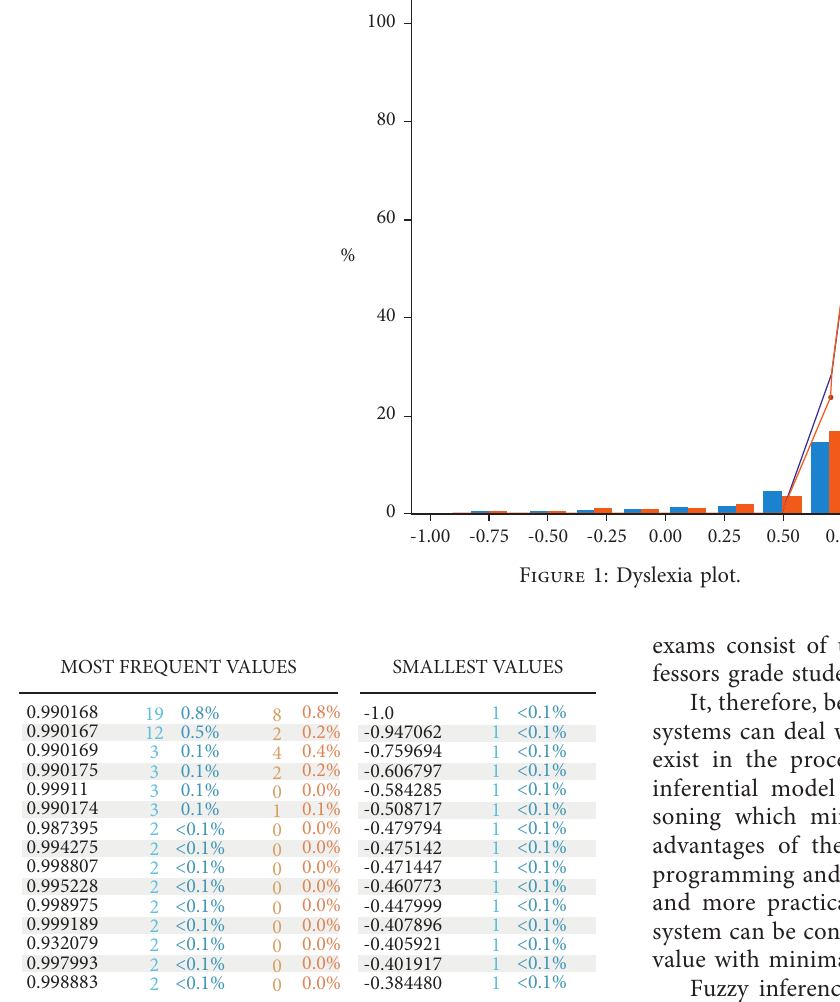
Figure 2: Dyslexia test